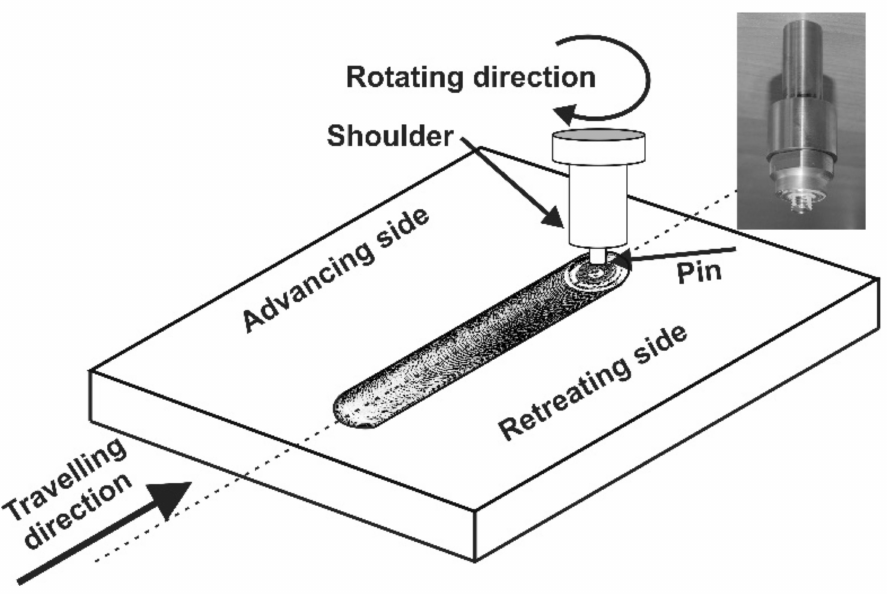
Figure 1. Schematic diagram of friction stir processing (FSP) modification; this figure also shows a photo of the Triflute